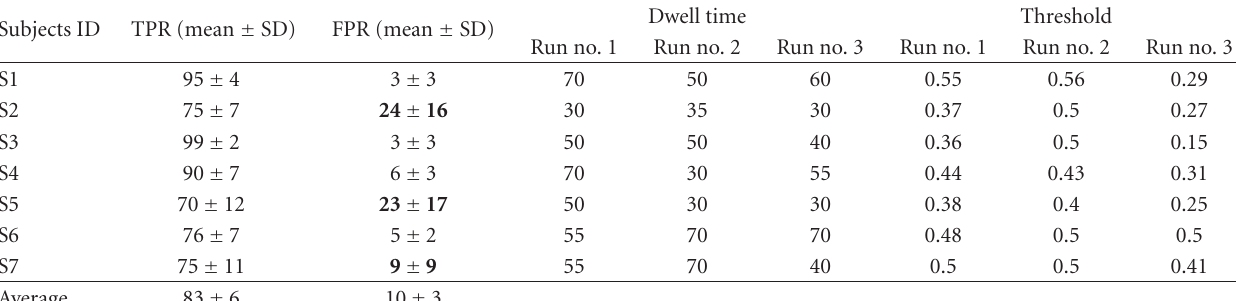
Table 2: Individual performance while the dwell time and threshold are automatically selected in training phase, the selected values also are written for each subject in 3 di ff erent combinations of runs. Run no. n shows the test run number. Subjects ID